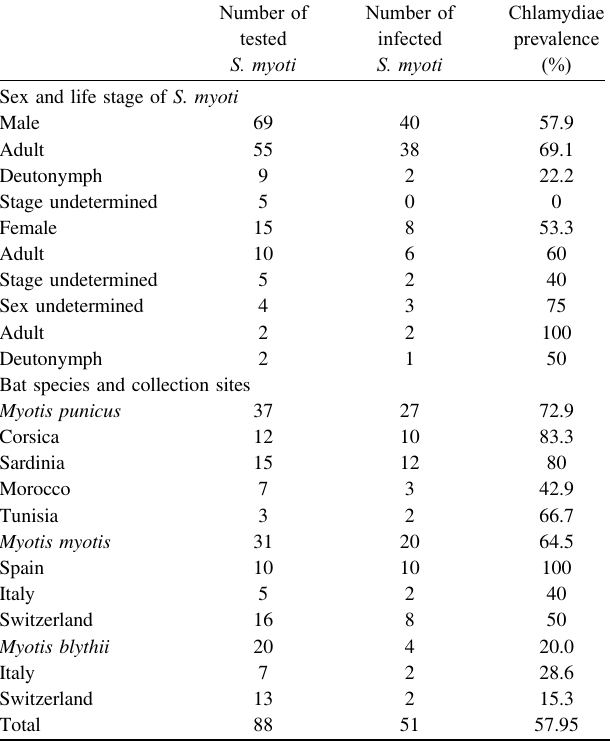
Table 1. Summary of Chlamydiae prevalence results as a function of sex and life stage of S. myoti and of bat host species and collection sites.